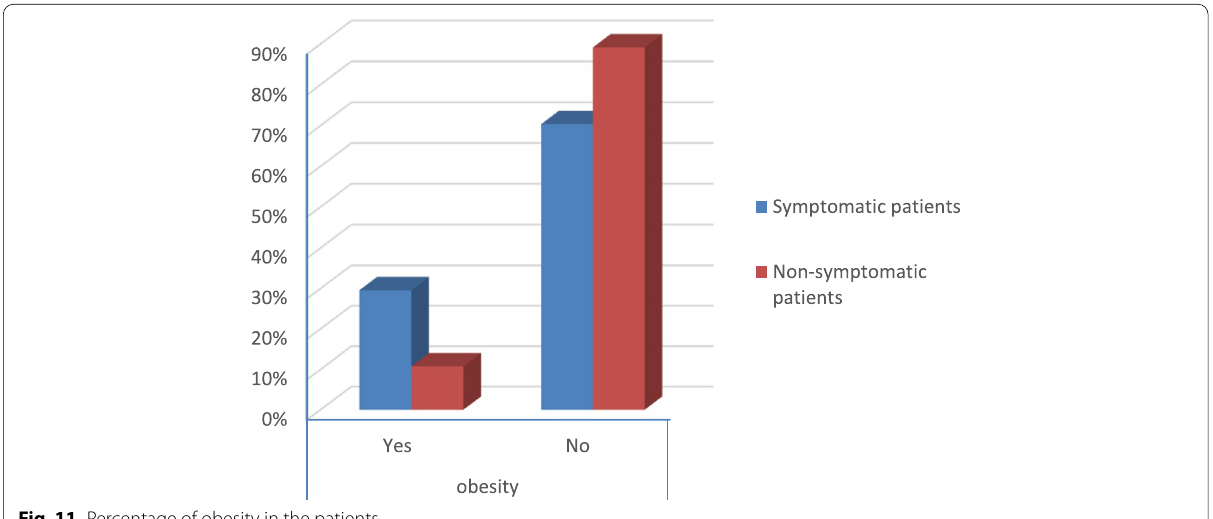
Fig. 11 Percentage of obesity in the